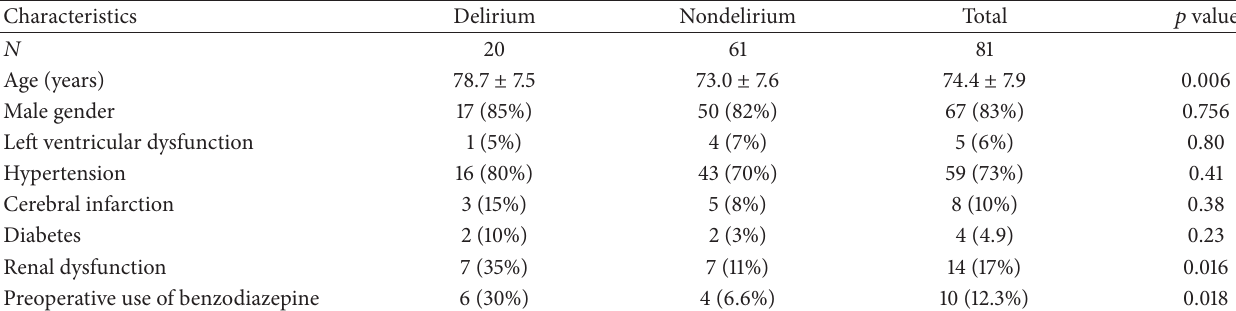
Table 1: Characteristics of patients who underwent elective endovascular aortic repair.